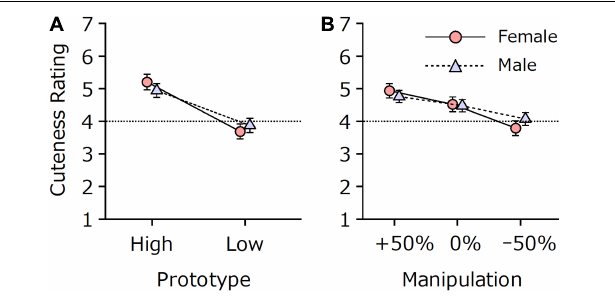
FIGURE 5 | Sex differences in cuteness ratings of prototype and manipulated faces. 1 = not cute (kawaii) at all , 7 = extremely cute (kawaii). Error bars indicate 95% confidence intervals. (A) The data on prototype faces. (B) The data on manipulated average faces.